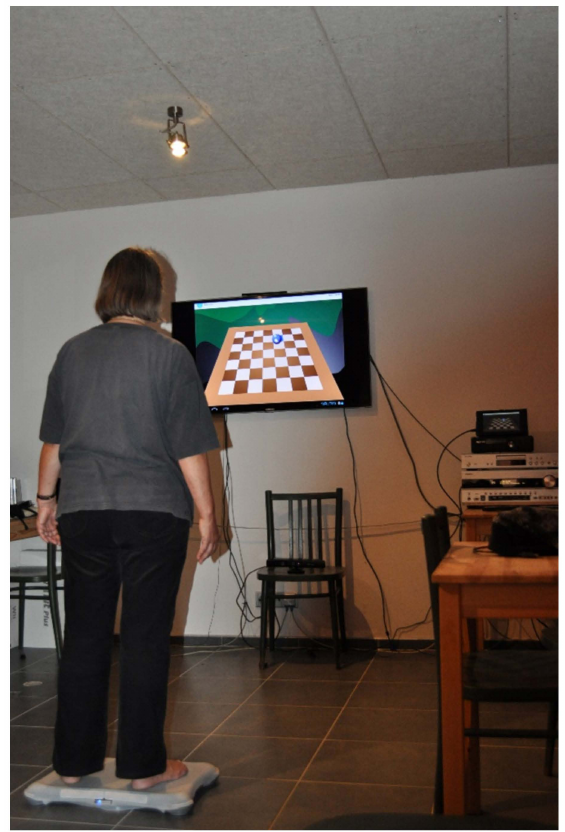
Figure 2. Patient during therapy with Homebalance. Patients with balance disorders are at a higher risk of falling and decompensating their health condition than the healthy population. Neurological patients may experience epileptic seizures when audio-visual feedback is used if under excessive physical